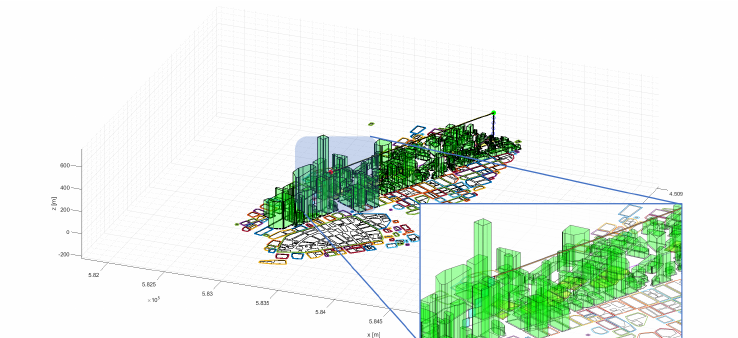
Figure 16. Example 3-D geofencing solution for a “constant cruise altitude” flight plan solution. Polyhedra in green denote keep-out geofences around buildings near the trajectory’s keep-in geofence. The remaining 2-D polygons denote keep-out geofences around buildings that are more distant from the sUAS flight